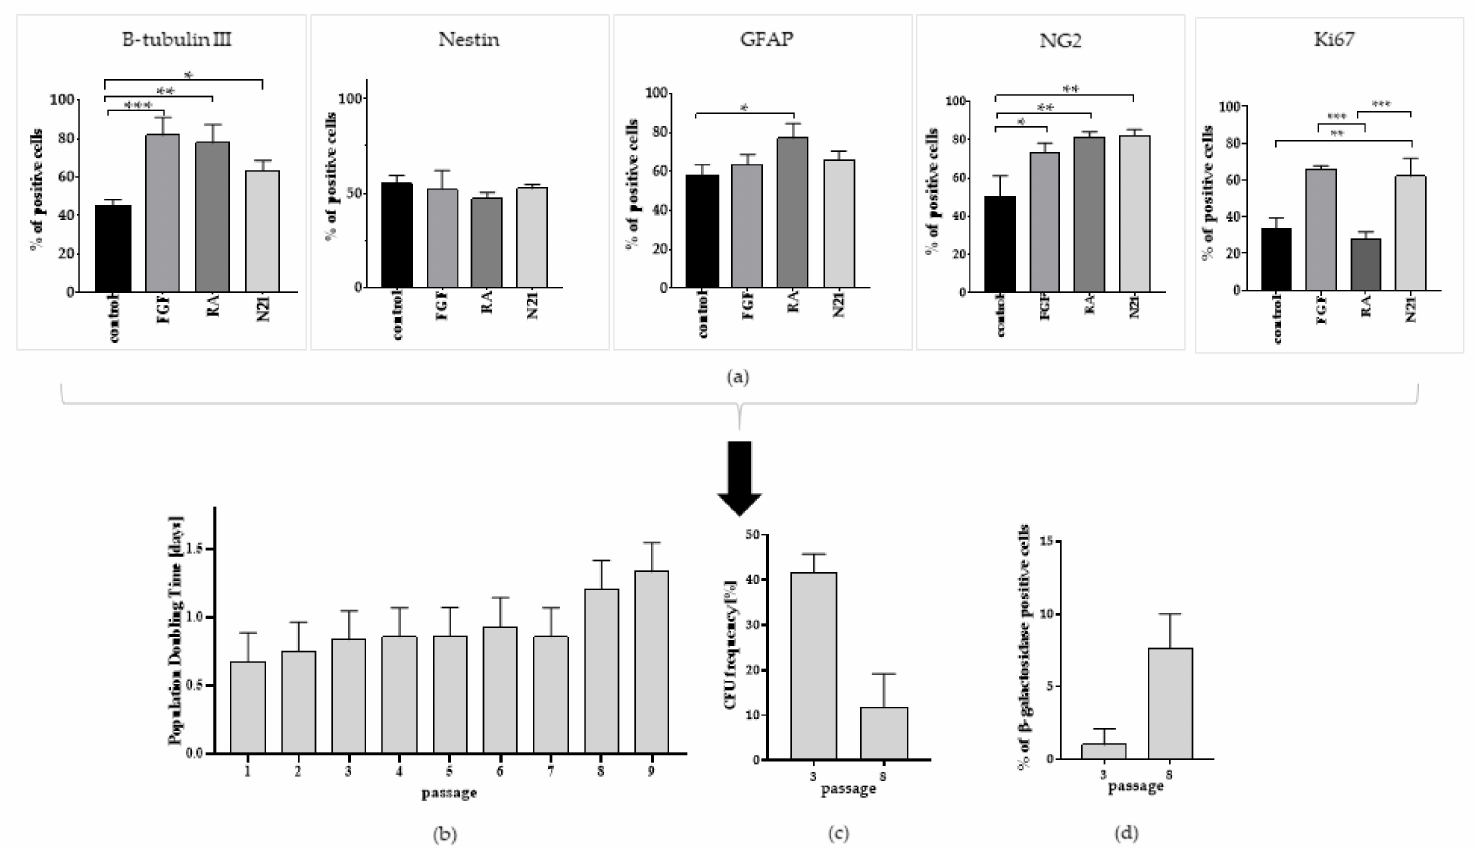
Figure 7. Optimization of ASCs’ capacity for neural lineage differentiation. ( a ) Quantitative analysis of neural (B-tubulin III, Nestin, GFAP, NG2) and proliferation (Ki67) markers presence in ASC culture in inducive of neurogenesis medium (with addition of FGF, N2, N21); ( b ) Estimation of Population Doubling Time of ASC culture in medium with N21 supplement; ( c ) Colony Forming Unit at early (3rd) and late (8th) passage of ASC culture supplemented with N21. ( d ) Percentage of senescent cells counted from early (3rd) and late (8th) passage of ASC supplemented with N21. The results are presented as mean values of three experiments ± SEM. The differences were considered statistically significant when p -value <0.05. Statistical significance level * for 0.01 < p < 0.05; ** for 0.001 < p < 0.01; *** for 0.0001 < p < 0.001; **** for p <